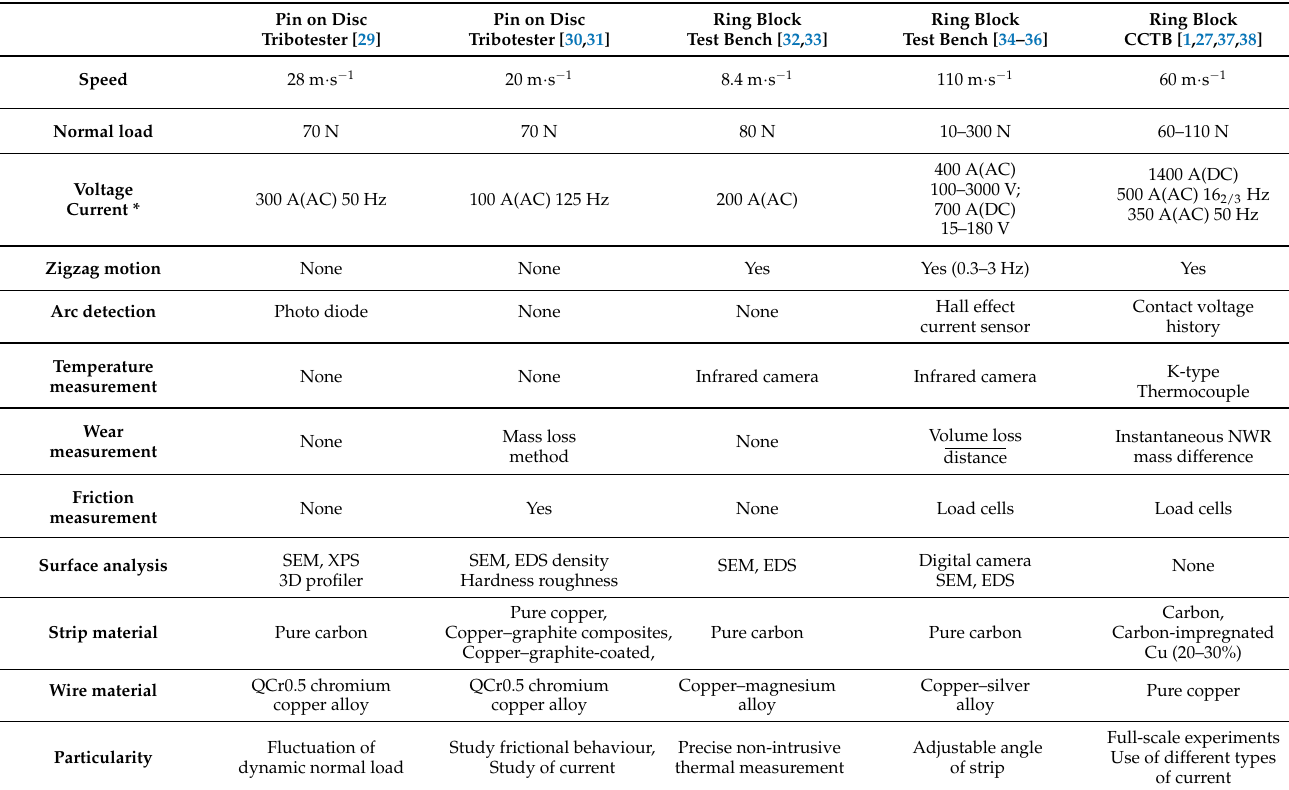
Table 1. List of test benches used to study pantograph–catenary contact *. A(AC) stands for alternative current and A(DC) for direct